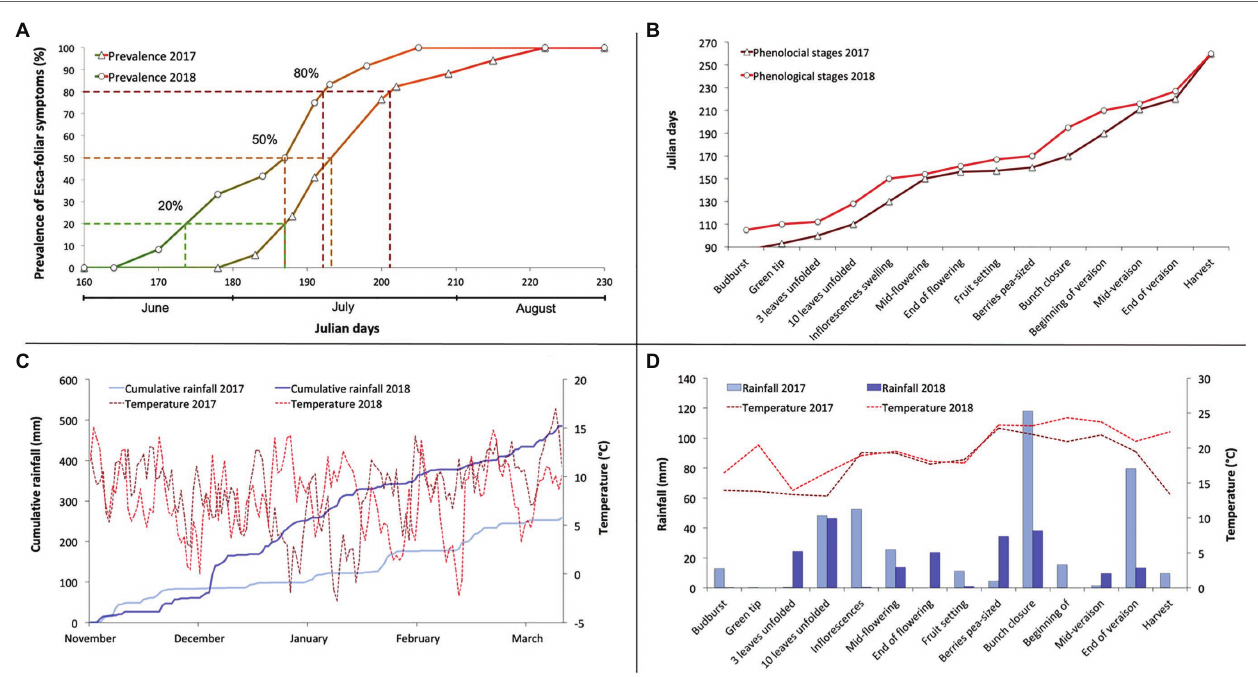
FIGURE 1 | Characterization of the sanitary, phenological, and climatic context of the 2-year physiological monitoring period, showing (A) the evolution of the prevalence of Esca-foliar symptoms in 2017 and 2018, (B) the chronology of the main phenological stages in 2017 and 2018, (C) the comparison of winter cumulative rainfall and temperatures during the 2017 and 2018 winter seasons, and (D) the comparison of rainfall and temperatures during the 2017 and 2018 growing